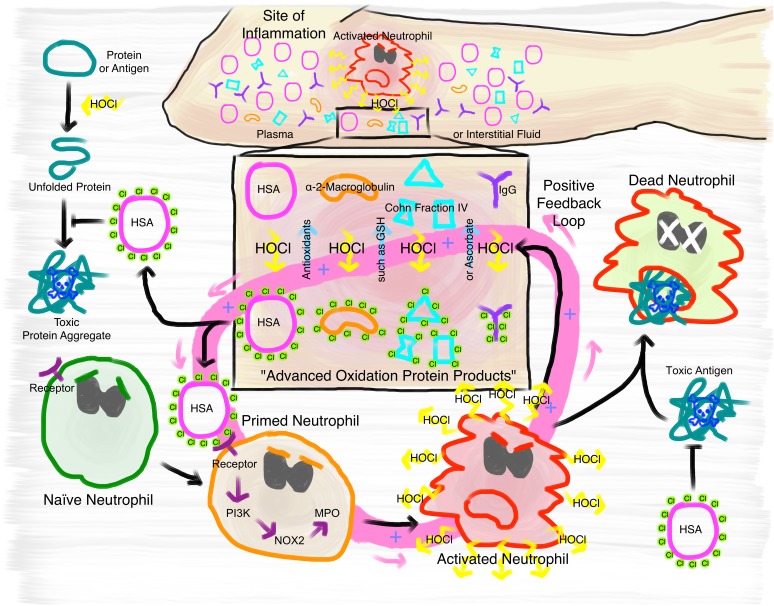
Proposed mechanism of the immunomodulatory role of N-chlorination of plasma proteins at a site of inflammation.At the site of inflammation neutrophils (and potentially other immune cells) are activated. Neutrophils then produce HOCl at concentrations of up to 25 to 50 mM per hour. Plasma proteins, such as HSA, α- and β-globulins (Cohn Fraction IV), γ-globulins (IgG), and α2-Macroglobulin then act as an effective sink. Reversible N-chlorination of these proteins turns them into effective chaperons, which can prevent the formation of protein aggregates and their uptake by immune cells, enhancing the survival of neutrophils in the presence of toxic antigens. N-chlorinated plasma proteins also activate more immune cells, which then in turn produce more HOCl, leading to the formation of more N-chlorinated plasma proteins. This positive feedback loop can be attenuated and deactivated by antioxidants present in plasma, such as ascorbate and reduced glutathione (GSH).